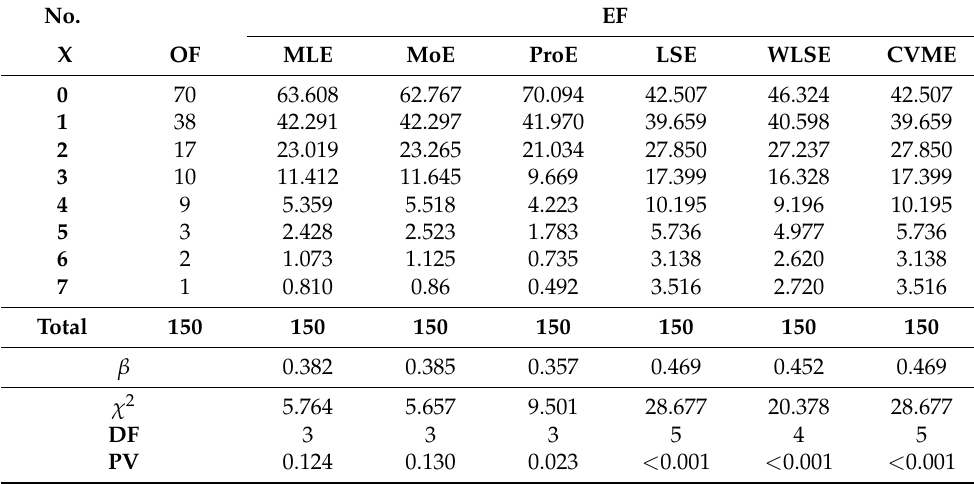
Table 7. CVE for data set I.